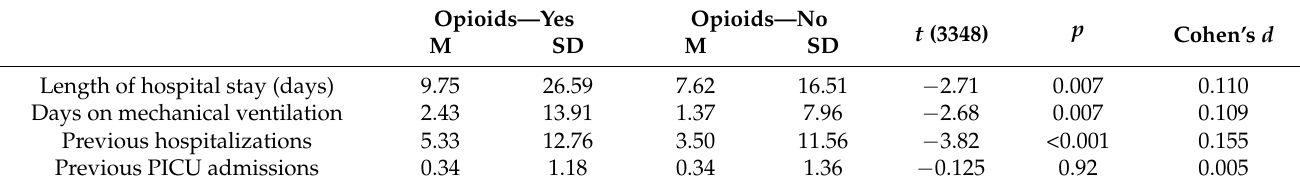
Table 3. Group differences on clinical factors by opioid prescription (yes/no) at discharge. Opioids—Yes